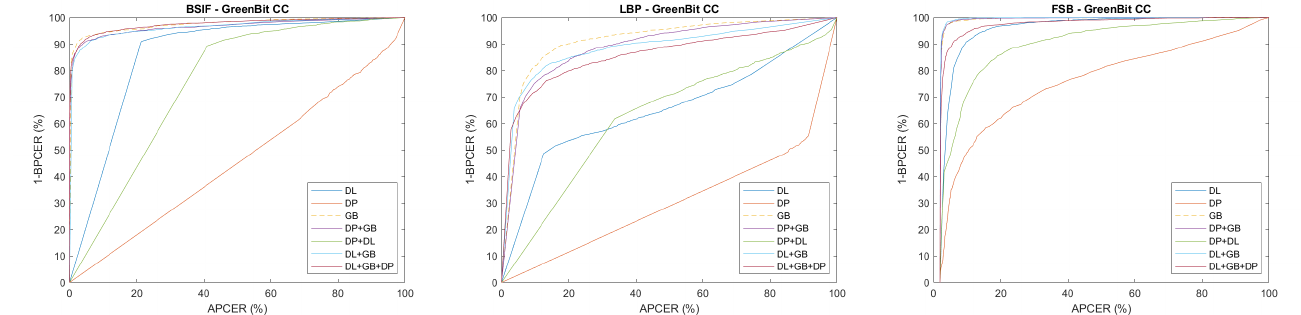
Figure 7. Comparison between ROCs of our self-trained PAD systems in an intra- (dashed) and cross- (solid) sensor scenario on the Dermalog ScreenSpoof dataset from LivDet 2021.